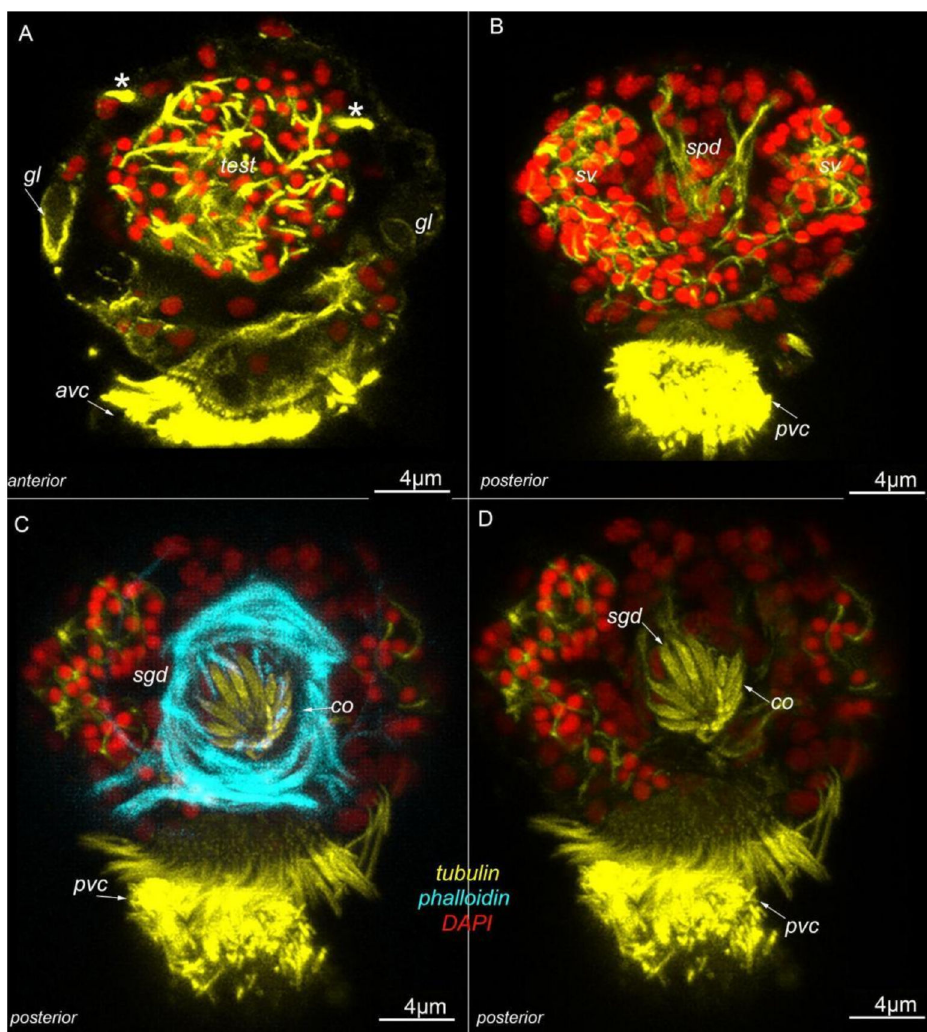
Figure 4. The internal organization of Dimorphilus gyrociliatus dwarf male. ( A – D ) optical cross- sections of the anterior ( A , B ) and posterior ( C , D ) parts of the body. ( A ) Prominent testis ( test ) and a pair of protonephridia (*), a pair of surface gland cells ( gl ). ( B ) symmetrically located seminal vesicles ( sv ) and unpaired spermioduct ( spd ). ( C ) Copulatory organ—glandomuscular organ, includes glandular part, represented by stylet gland cells ( sgd ) and muscle part (cyan). ( D ) The same section as ( C ); without cyan channel, thus only stylet gland cells are visible, without